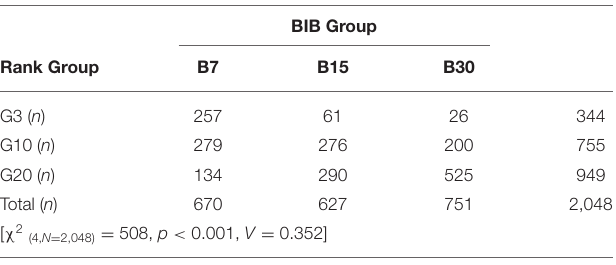
TABLE 4 | Number of placings for different starting groups in men’s FIS World Cup Giant Slalom